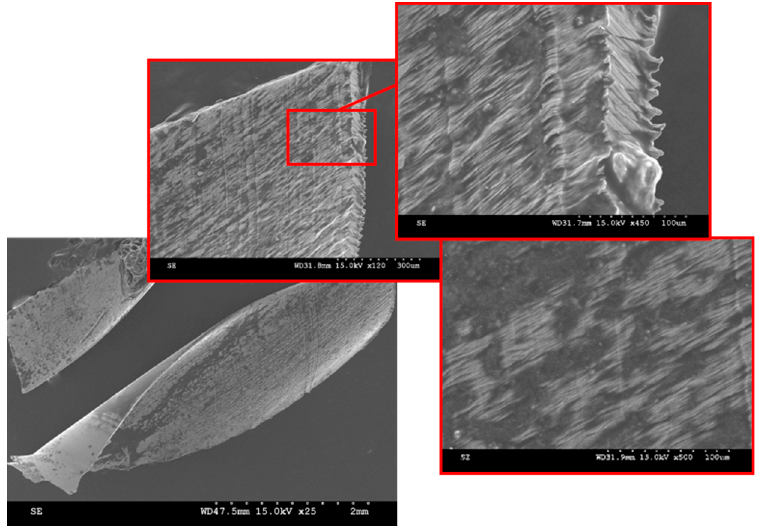
Figure 18. Surface microstructure and chip color due to elevated temperature in the drilled holes.